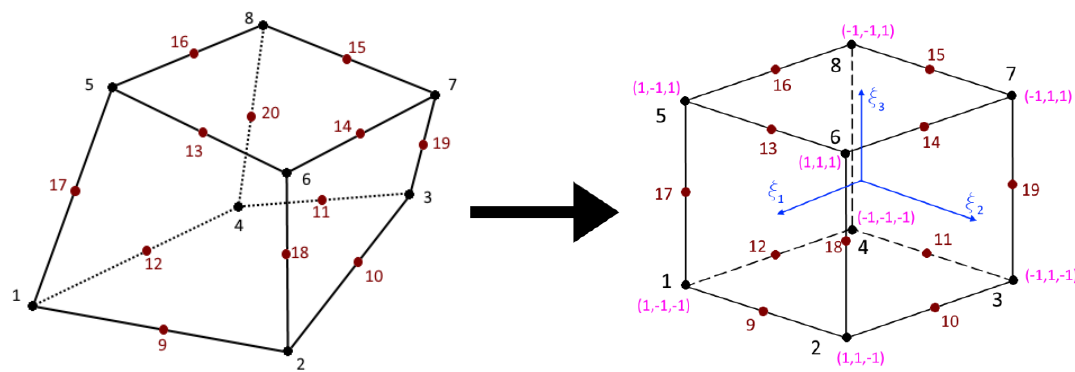
Figure 3. Iso-parametric 20-noded 3D finite element: physical configuration—left graph, normalized local coordinate system—right graph.